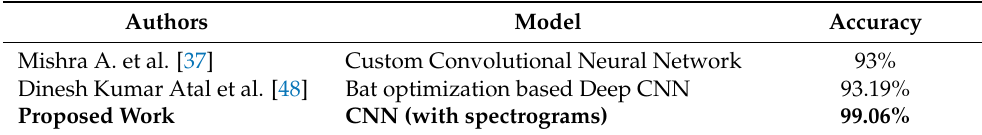
Table 2. Assessment with similar classification model.